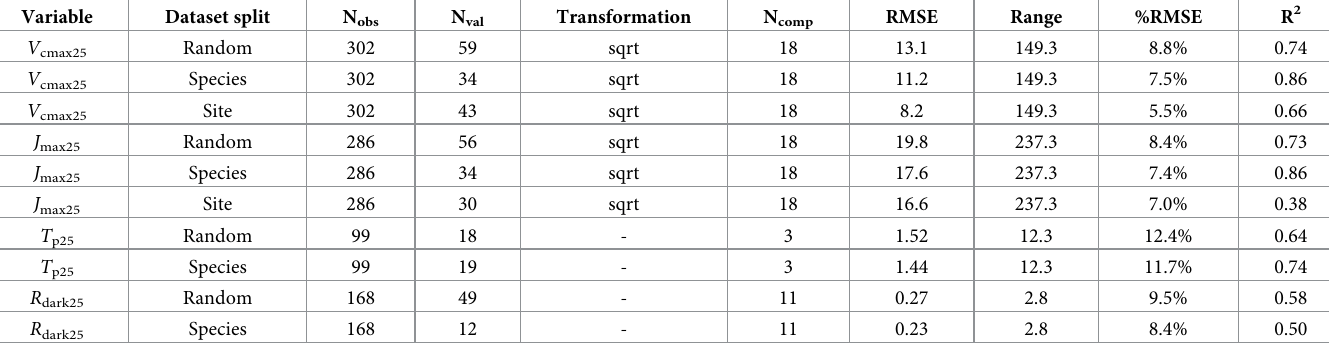
N obs represents the total number of observations in the training and validation datasets. N val represents the number of observations in the validation dataset from which the Root Mean Square Error (RMSE), the percent RMSE (%RMSE) and R 2 are calculated. N comp is the number of components of the PLSR model. The range corresponds to the difference between the maximum value of the parameter and its minimum over the whole dataset and is used to calculate the %RMSE.